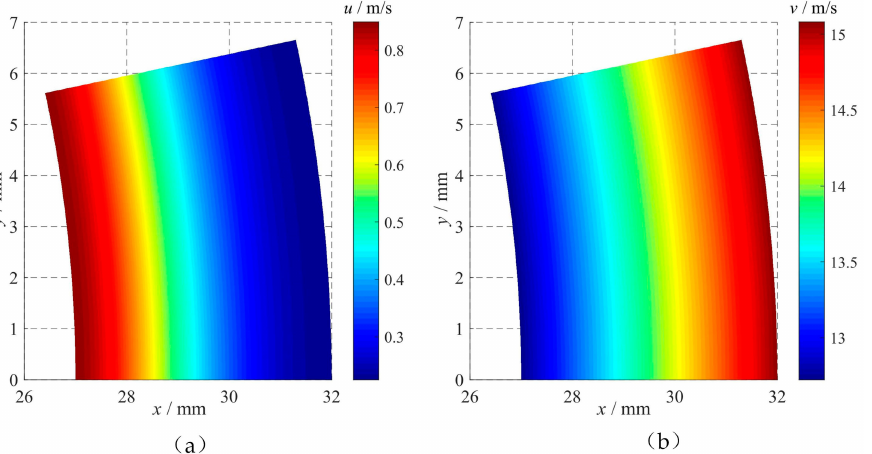
Figure 7. Radial velocity and angular velocity distribution of oil film without textures (( a ) is radial velocity; ( b ) is angular velocity).